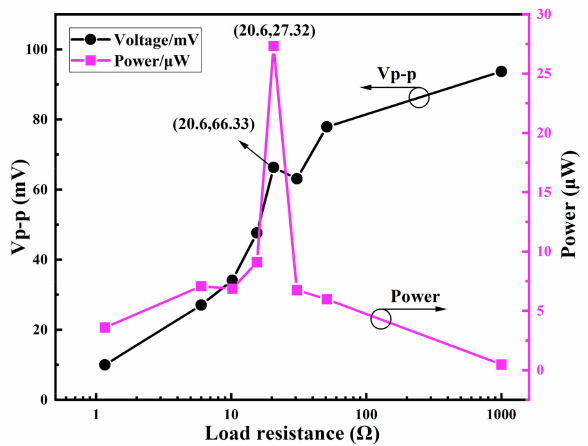
Figure 8. Peak-to-peak voltage and averaged power under different load resistances at 36